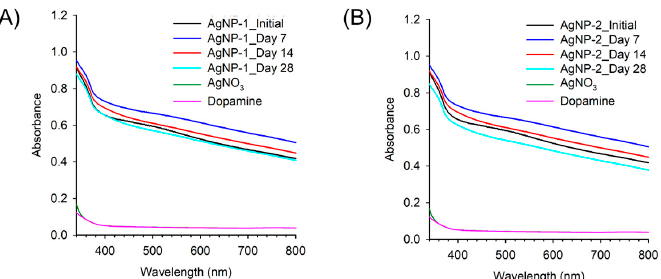
Figure 2. UV–vis absorbance spectra of ( A ) AgNP-1 and ( B ) AgNP-2 tracked for 28 days after being stored at 25 °C.